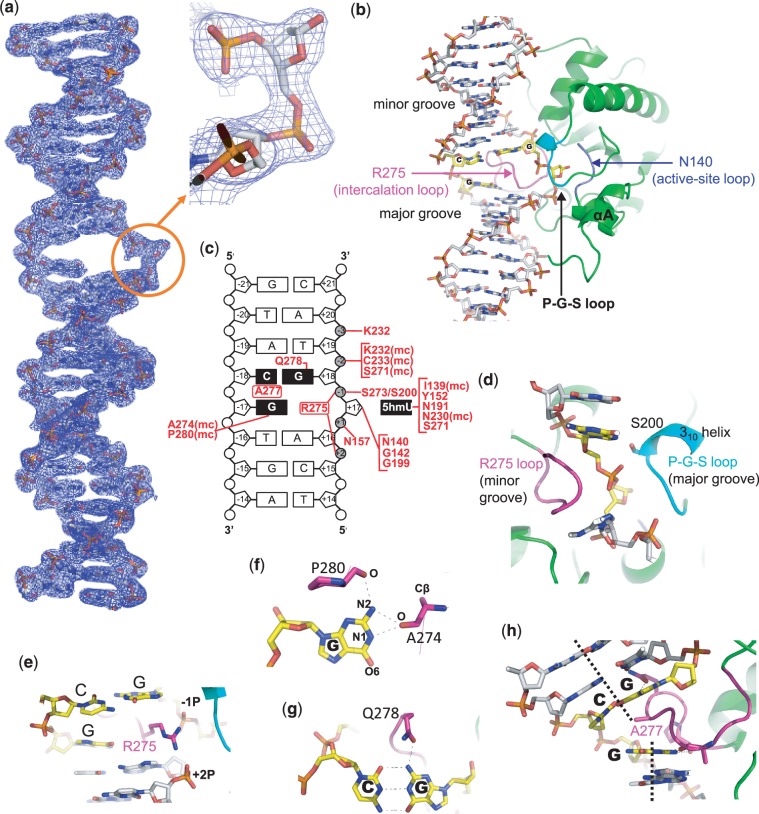
Structure of TDG in complex with G:5hmU containing DNA. (a) 2Fo-Fc electron density, contoured at 1σ above the mean, for the entire 28-bp DNA used in the TDG structure determination. The insert is an enlarged abasic sugar with a hydrolyzed C1′. (b) Overall structure of the WT TDG complex. DNA is in stick model, and TDG is in ribbon model. The Arg275-containing loop is colored in magenta, the P-G-S loop is in cyan and catalytic loop in blue. (c) Summary of the TDG–DNA interactions: mc, main-chain-atom-mediated contacts; black boxes represent the CpG sequence and extrahelical 5hmU. (d) The Arg275-containing intercalation loop (in magenta) and the P-G-S loop (in cyan) approach the modified DNA strand from opposite directions. (e) Arg275 penetrates into the DNA helix from the minor groove. (f) The three hydrogen bonds formed with the intrahelical orphaned guanine. (g) Gln278 forms a hydrogen bond from the minor groove side with Gua of the adjoining G:C base pair. (h) Ala277 intercalates between the central Cyt and Gua of the unmodified strand.